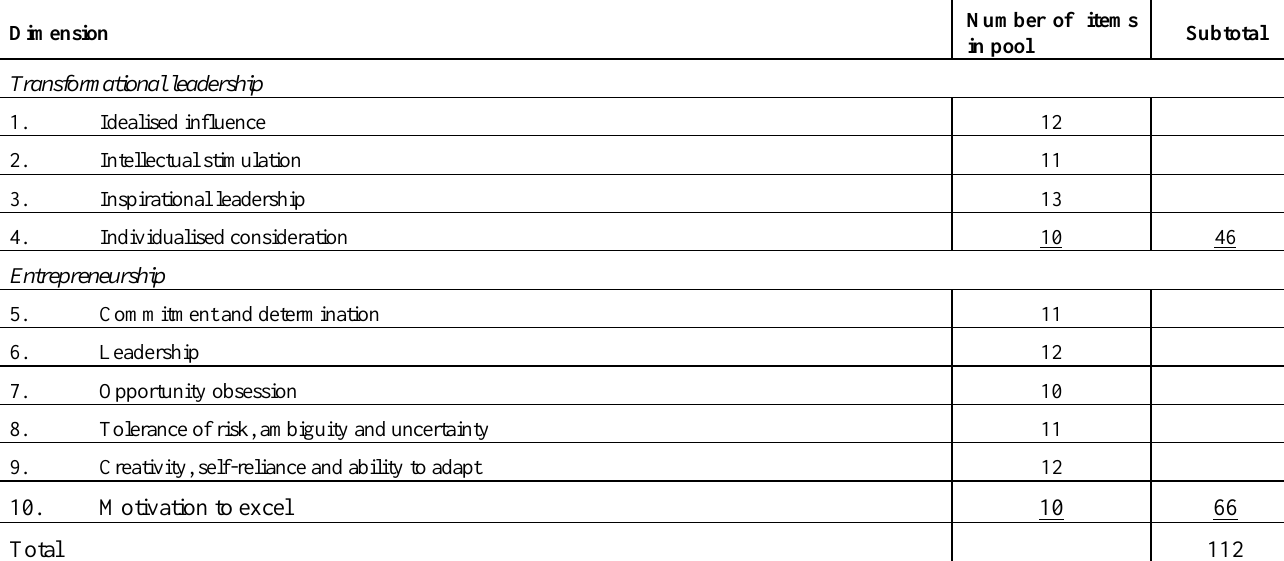
Number of items